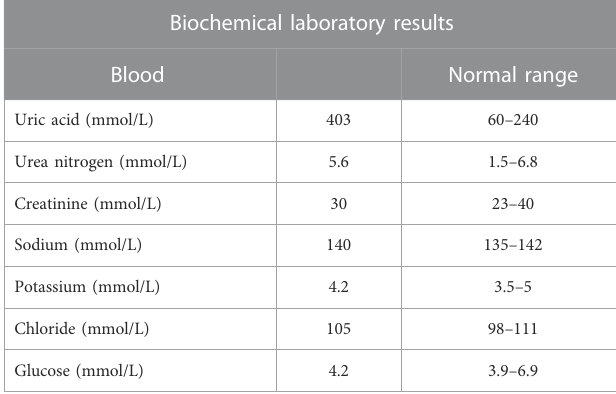
TABLE 1 Biochemical laboratory results of the